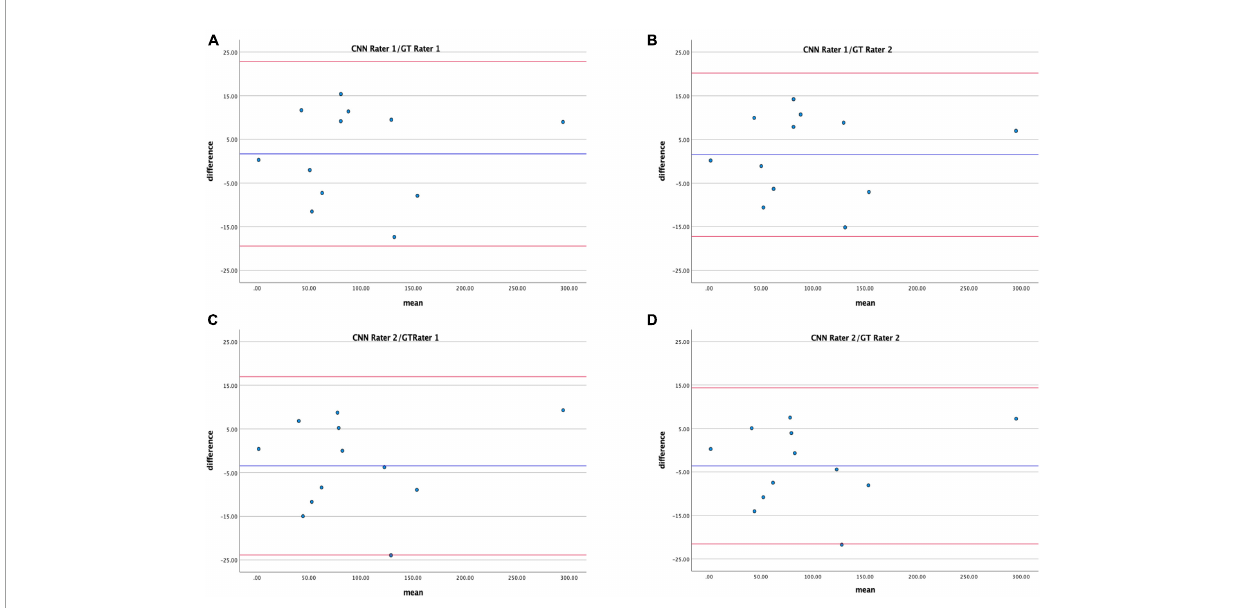
FIGURE7 Bland–Altman plots showing agreement between total hypo-perfuse volume measurements derived from CNN and GT maps for Rater 1 (A,B) and Rater 2 (C,D)